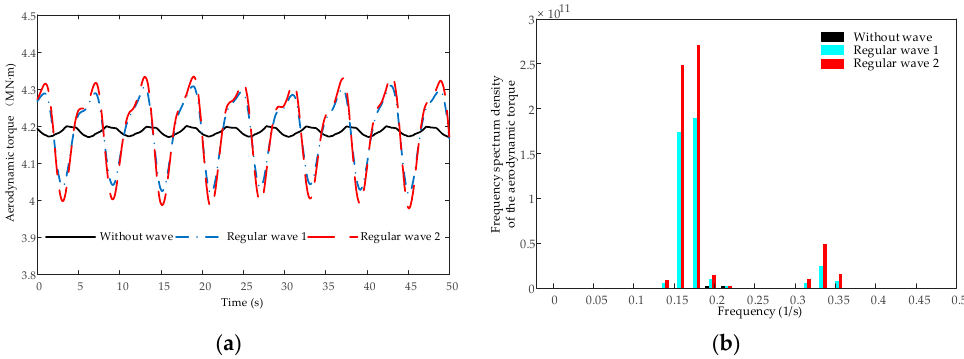
Figure 6. Time domain and frequency domain results of the aerodynamic torque without and with regular wave: ( a ) The aerodynamic torque; ( b ) Frequency spectrum density of the aerodynamic torque.